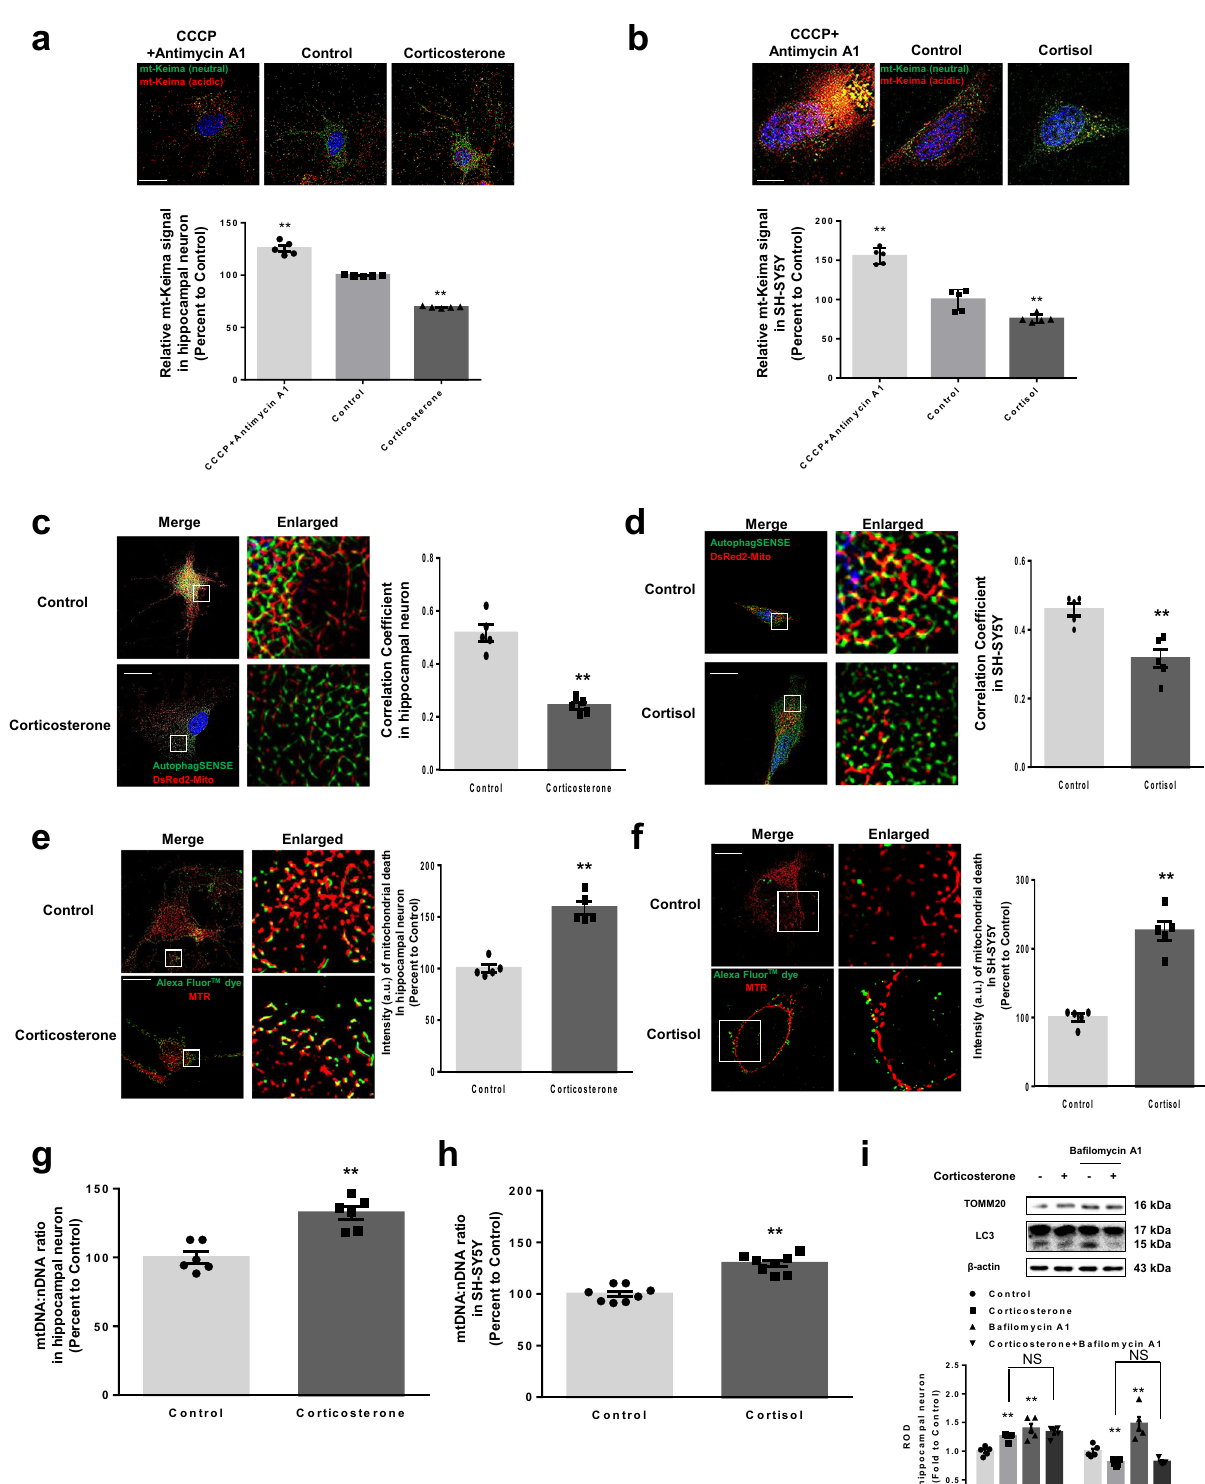
also performed immunoprecipitation and immunocytochemistry to detect the ubiquitination of mitochondria, the primary downstream event of PINK1-parkin signaling. Ubiquitination of TOMM20 was not altered by cortisol treatment (Supplementary Fig. 3c). Furthermore, the interaction between ubiquitin and Mfn1, another PINK1-parkin substrate, was unchanged